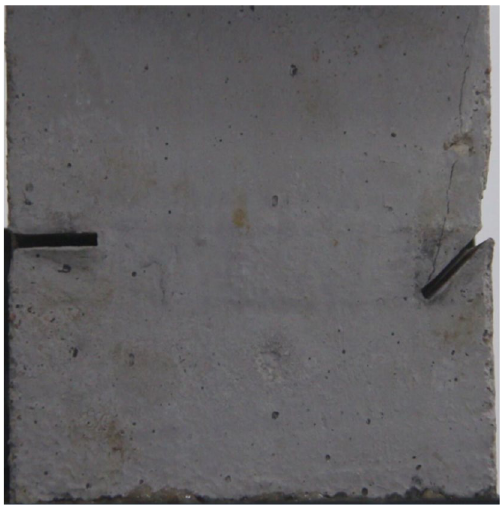
Figure 24. Photograph of a specimen showing anti-tensile wing crack